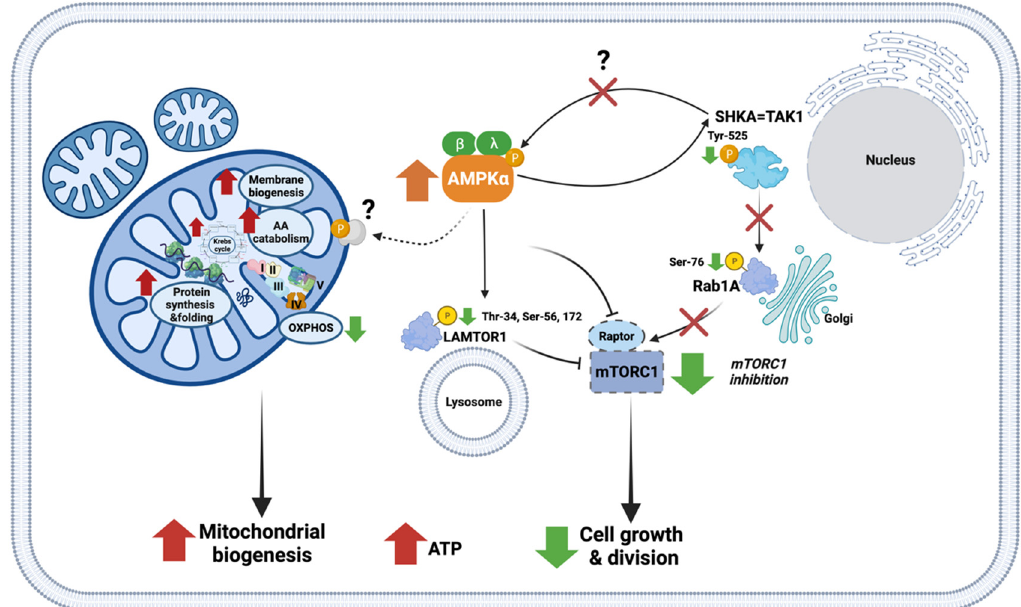
Figure 6. A hypothetical scenario of the events leading to enhanced mitochondrial biogenesis and reduced growth rate of D. discoideum vegetative cells in the presence of chronically active catalytic AMPK α subunit. The directions of short green, red and orange arrows specify either change in the protein abundance/phosphorylation level or direction of a specific process in the presence of chronically active AMPK α subunit. Black lines ending with arrowheads indicate activating effects, while perpendicular lines indicate inhibiting effects. Black dotted lines indicate hypothetical processes. Chronically active AMPK leads to the inhibition of the mTORC1 pathway via dephosphorylation-dependent events including the SHKA-Rab1A-mTORC1 route and/or the AMPK-LAMTOR1-mTORC1 pathway, which in consequence results in a decrease in cell growth and division. Enhanced mitochondrial biogenesis is induced by not yet identified mitochondrial protein target which upon direct or indirect phosphorylation by AMPK leads to dramatic changes in the abundance and/or phosphorylation-dependent activity of mitochondrial proteins involved in energy metabolism, protein synthesis and membrane biogenesis. This in turn causes the presence of increased mitochondrial mass and level of cellular ATP. SHKA, dual-specificity protein kinase SHKA; Ras1A, Ras-related protein Ras1A; mTORC1, mechanistic target of rapamycin complex 1; LAMTOR1, Ragulator complex protein Lamtor1. Created with BioRender.com.